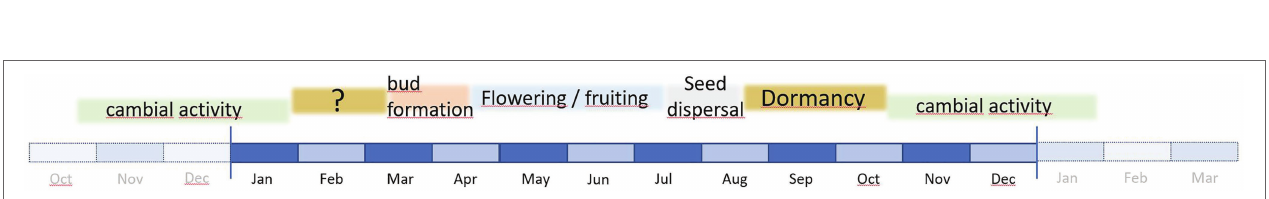
FIGURE 7 | The scheme illustrates the onset and duration of the phenological stages (compare to Figure 2 ) and the period of cambial activity as determined by the results of the pinning experiment. The period marked with “?” most likely refers to bud formation, although this requires further studies on phenology of